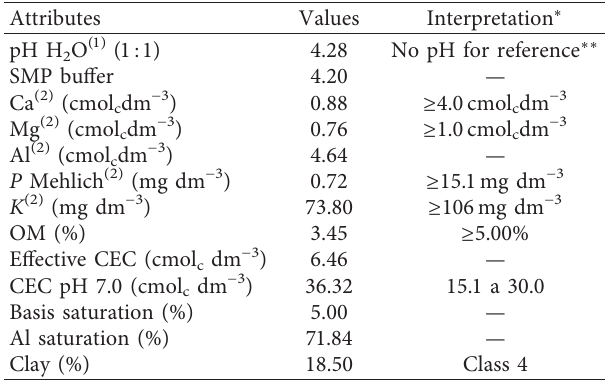
Table 1: Chemical and physical characteristics of the soil in the 0–20 cm depth layer of the study